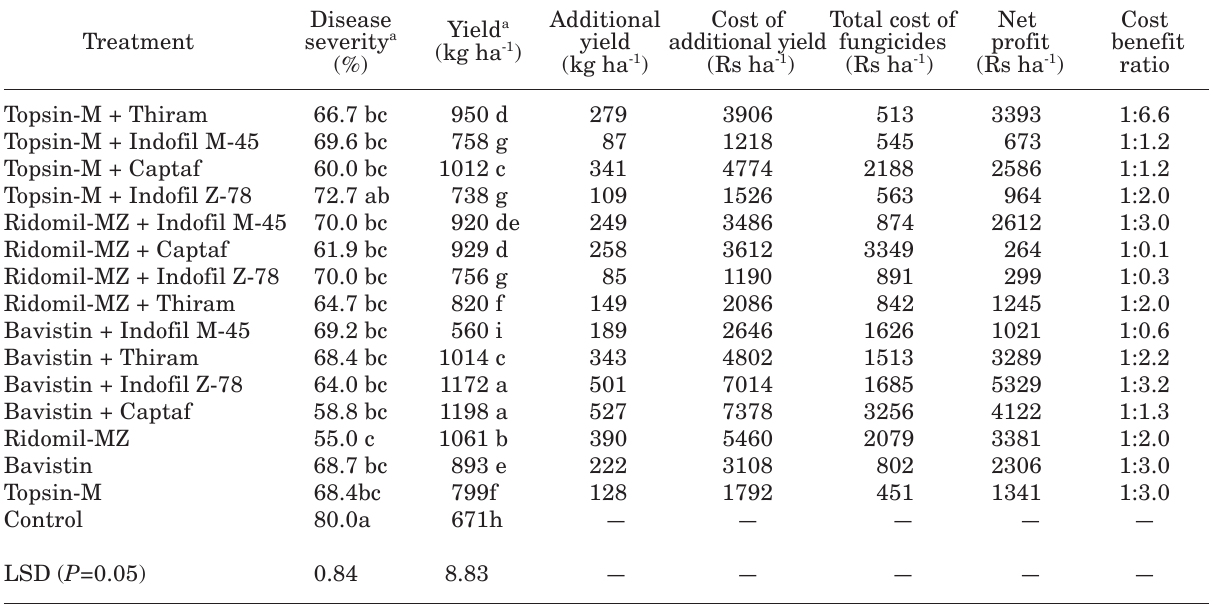
Table 3. Evaluation of different fungicides in foliar sprays against Alternaria blight on Brassica campestris var. yellow sarson (Alankar) under field conditions.